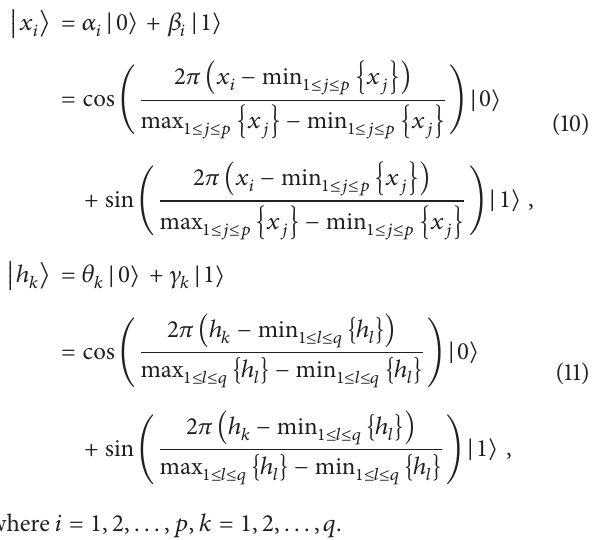
Figure 3: Two qubit controlled-NOT gates.